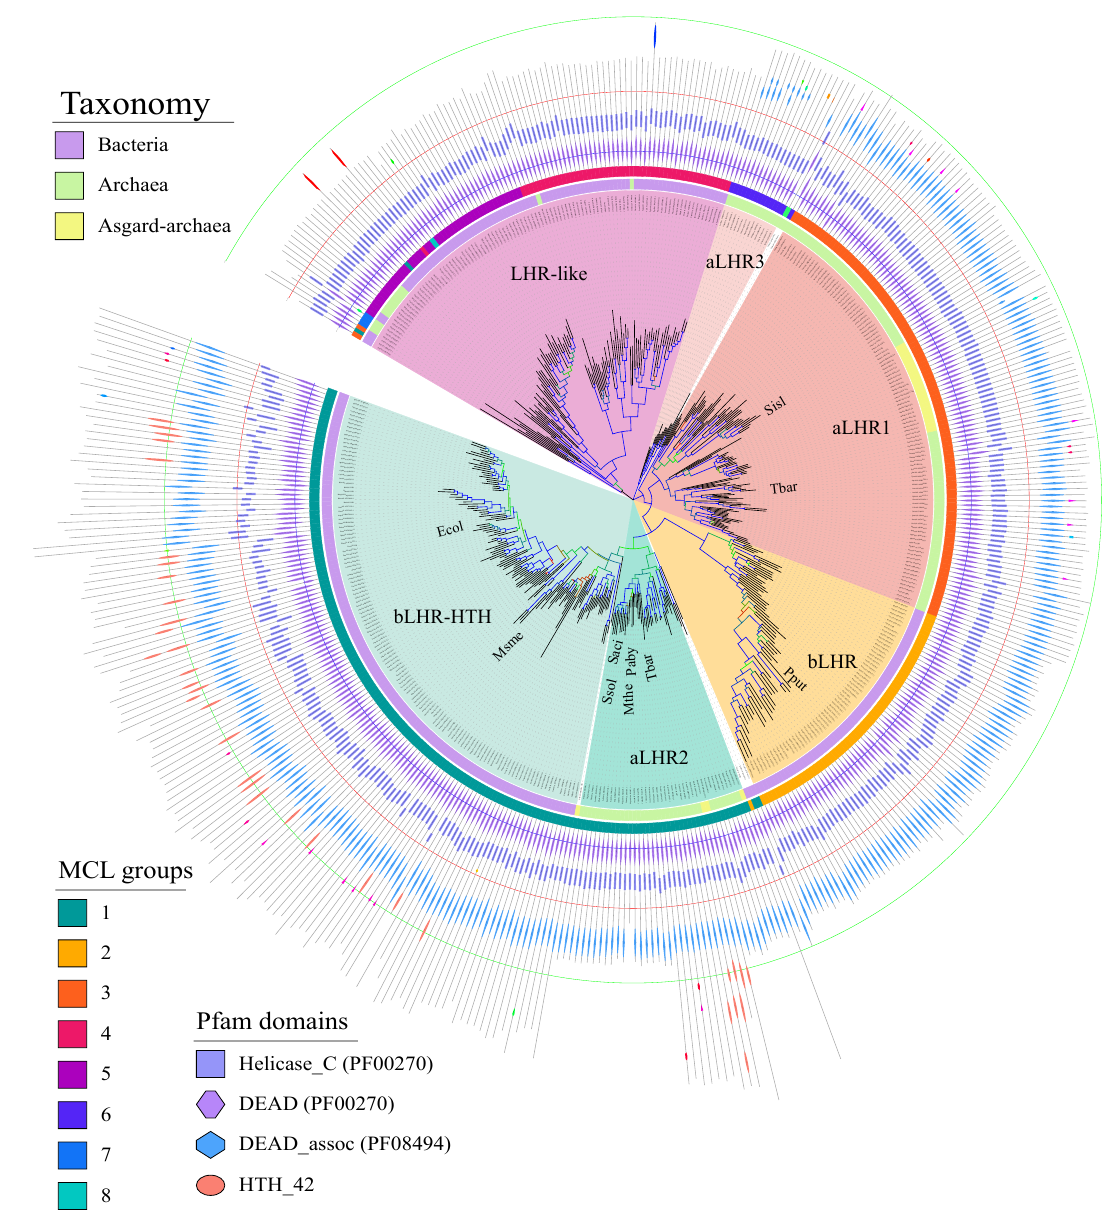
Figure 2. Phylogenetic tree and domain organization of archaeal and bacterial Lhr representative sequences. The tree is rooted to the branch that separates the subtrees Lhr-like and aLhr3. The branches are coloured according to their bootstrap value using a colour gradient from red (bootstrap value of 0) to blue (bootstrap value of 100) with flashy green at midpoint values. The taxonomic origin of the sequences is shown in the first outer ring: purple for Bacteria, light green for all Archaea except for Asgard, shown in yellow. The MCL subclasses obtained with an IF of 4 are shown on the second outer ring and colour-coded as indicated in the legend panel “MCL groups”. To highlight the different subfamilies, their corresponding subtrees are coloured and the sequences to which the location on the tree and the MCL classification do not correspond are left white. The locations of reference sequences are indicated at their respective leafs ( Tbar , Sisl ) or at the leaf of their representative medoid ( Msme , Ecol , Pput , Ssol , Saci , Mthe , Paby ). Pfam motif architecture for each member is specified at the circumference of the tree. Their colour code is given in the legend panel “Pfam domains”. The sequence identifiers for each subtree are in Supplementary Table S2A,B. The tree display was obtained with online iTOL [29] (https://itol.embl.de/; accessed on 3 May